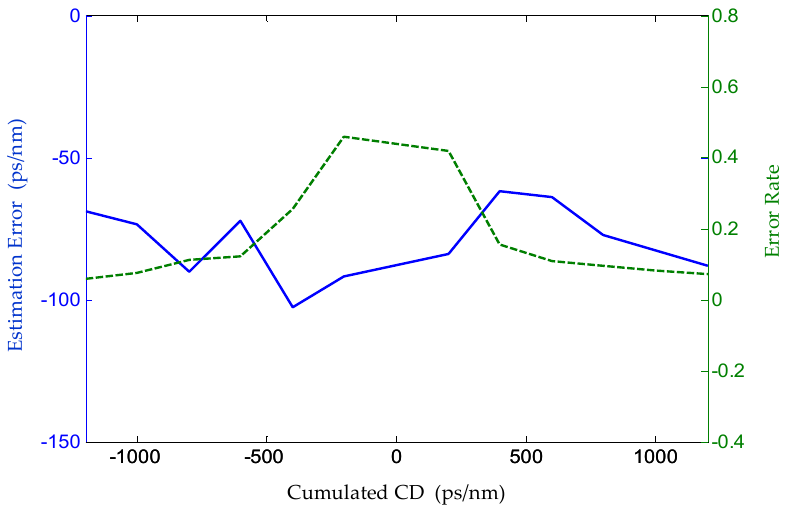
Figure 17. Estimation error and error rate results of OOK signal in different dispersion ranges. In order to evaluate the influence of different input powers on the CD estimation performance in the experimental environment, we choose to estimate the CD of the OOK signal under different input powers (respectively, − 2 dBm, 0 dBm, 2 dBm). The estimation error results are shown in Figure 18. It can be seen from the figure that within the real set cumulative CD range, the estimation errors under different input powers fluctuate within the fixed error range, and all estimation errors are within ( − 150 ps/nm, 0 ps/nm). It can be seen from the above that the change of the input power will not have a great impact on the estimation effect. It also proves that the estimation of this method in the actual transmission system has great robustness to the input power. In conclusion, we believe that the proposed CD estimation method based on FrFT can have a good estimation effect on the actual transmission system under different cumulative CD ranges.